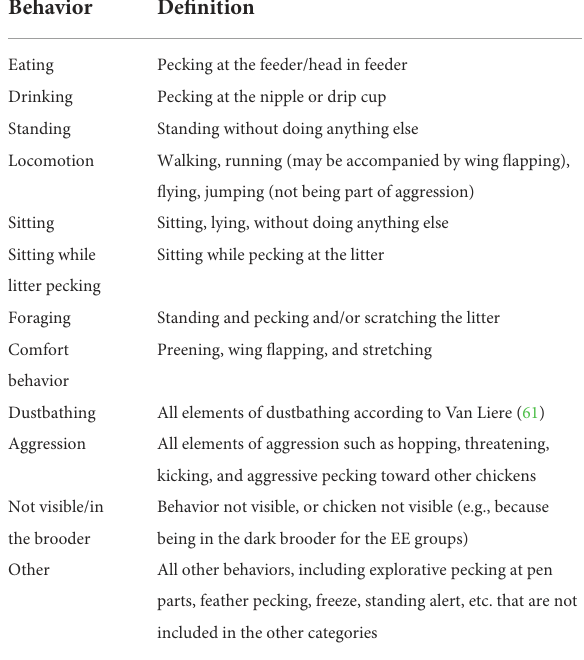
TABLE 1 Ethogram defining the different behavioral